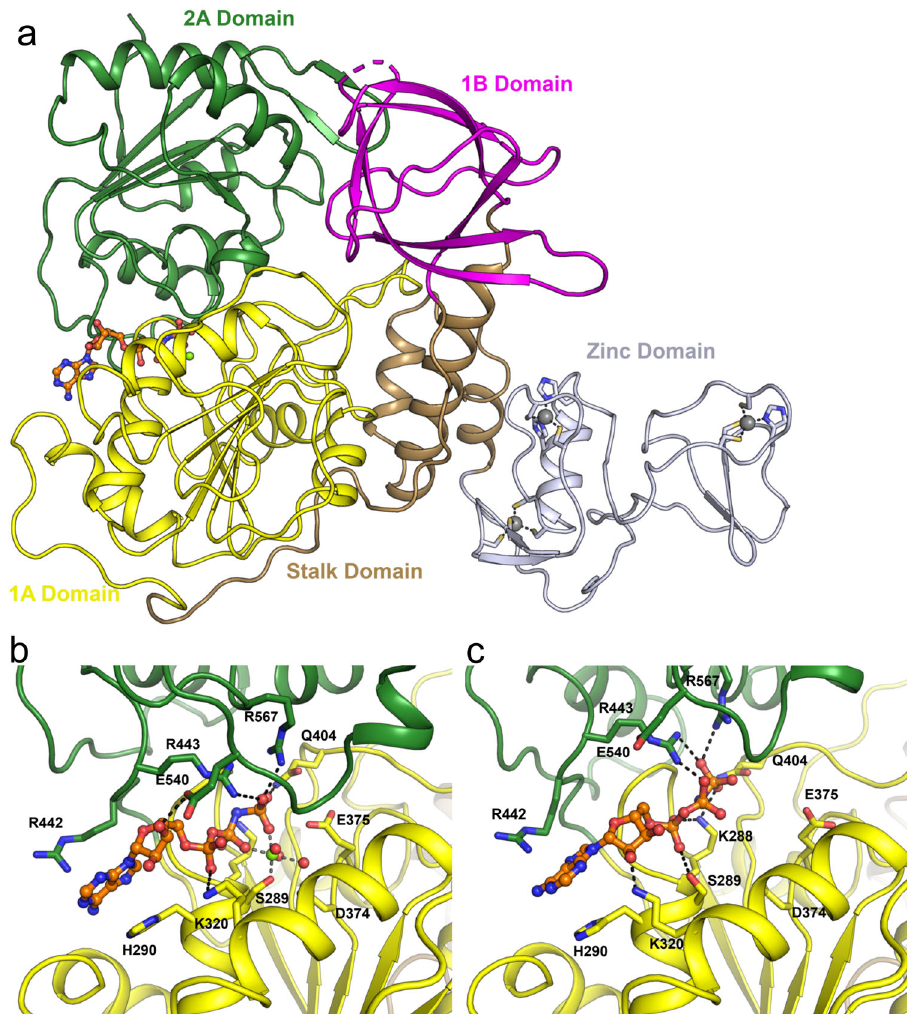
Fig. 1 Overall structure of SARS-CoV-2 NSP13. a Structure overview with domains labeled and colored individually (the same color scheme is used throughout). The AMP-PNP nucleotide is shown in stick format in the nucleotide binding site between the 1 A and 2 A domains. b Close up view of the nucleotide binding mode for the AMP-PNP Mg 2 + complex (mode A), with interacting residues labeled and shown in the stick format. c Close up view of the nucleotide binding form the AMP-PNP complex (mode B), viewed from the same orientation as panel ( b